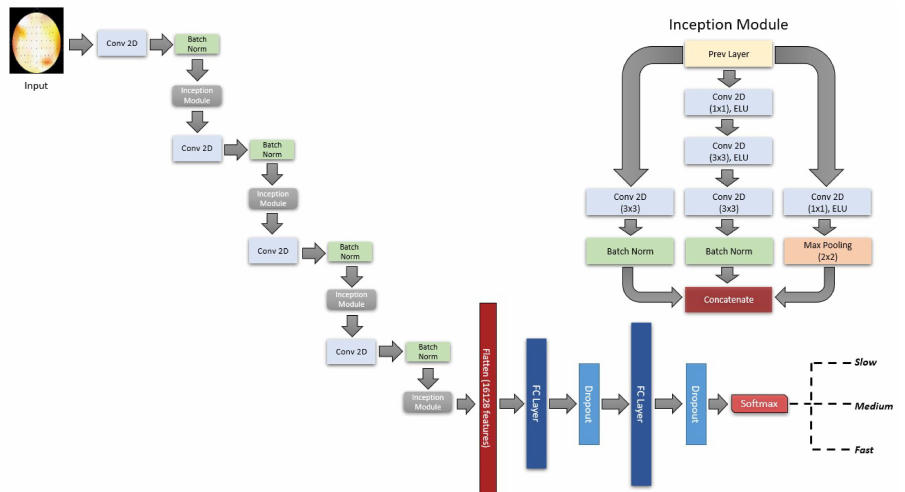
Figure 4. Network architecture selected by the TPE algorithm. The bandpower topomaps are the inputs of the model and are transformed through 4 consecutive convolution and inception reduction layers. The configuration of the Inception reduction layer is shown in the upper right corner. The first and interim convolution layers contain 52, 104, 156, and 208 filters with kernel size 5 × 5. The first and second FC layer contains 713 and 1019 units respectively with each of the FC layers followed by a dropout layer (rate = 0.47). The exponential linear unit (ELU) [41] function is used as activation for all the convolution and FC layers. The output layer contains 3 units with softmax activation corresponding to the 3 categorical RTs.